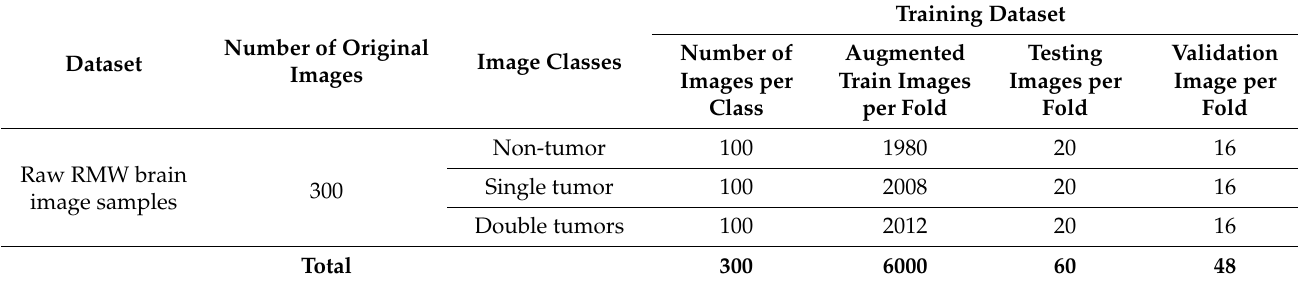
Table 3. Dataset description for training, testing, and